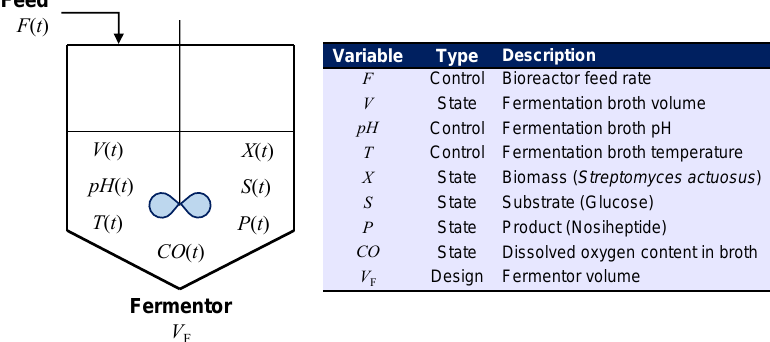
Figure 3. Fed-batch nosiheptide production via fermentation.